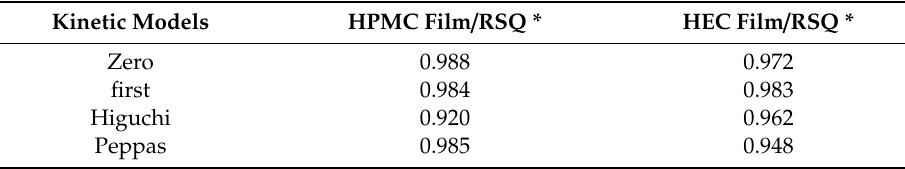
Table 4. The R-squared of the fitted kinetic models for di ff erent